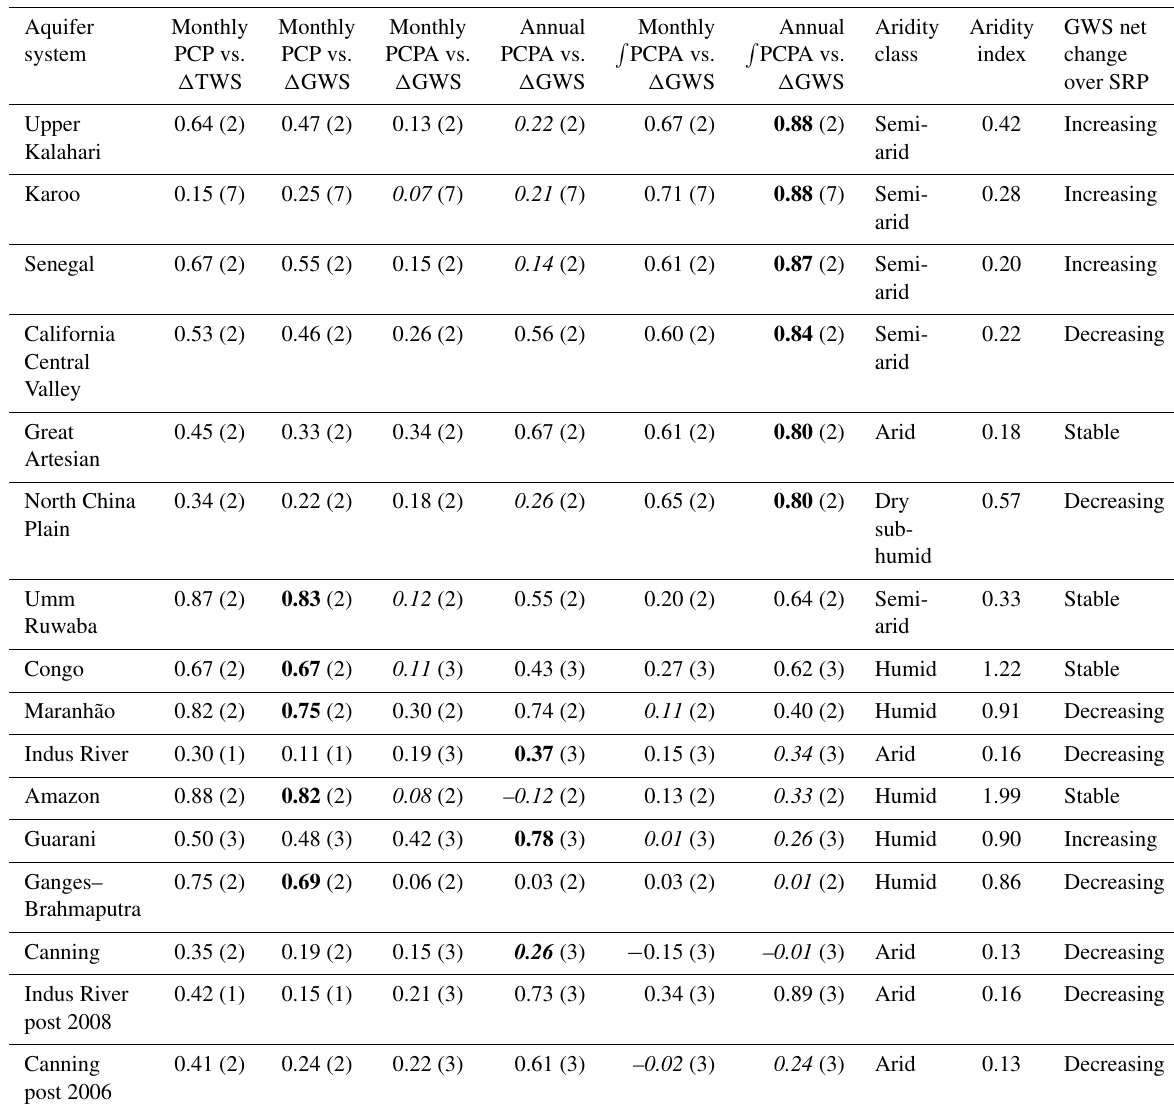
Table 3. Summary table of results from monthly and annual time series and aridity datasets. Summary of all correlation results from time series datasets (Pearson correlation coefficient and lag in months in parentheses) and the aridity indices derived from the CGIAR-CSI Global Aridity Index dataset (Trabucco and Zomer, 2019). (cid:49) GWS trend over SRP also shown. Results in italics fall below the t -test threshold. Aquifers are ranked in order of Pearson correlation coefficient for annual (cid:82) PCPA vs. (cid:49) GWS. For each aquifer system, the strongest (cid:49) GWS correlation with PCP or PCPA is shown in bold. Truncated time series results shown for two